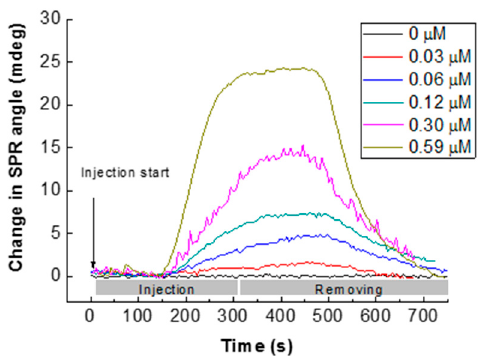
Figure 10. Typical sensorgrams of glyphosate sorption onto CS / ZnO SPR sensors for glyphosate concentration from 0 to 0.59 µ M (dead time corresponds to around 156 s between injection and the cell output).